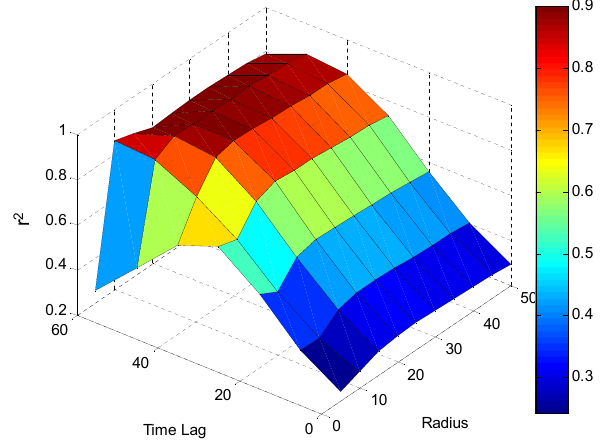
Fig. 3. Example of coefficient of determination for variable radius and time lag between flash count and precipitation timeframe for Chania precipitation station for event 1 (Table